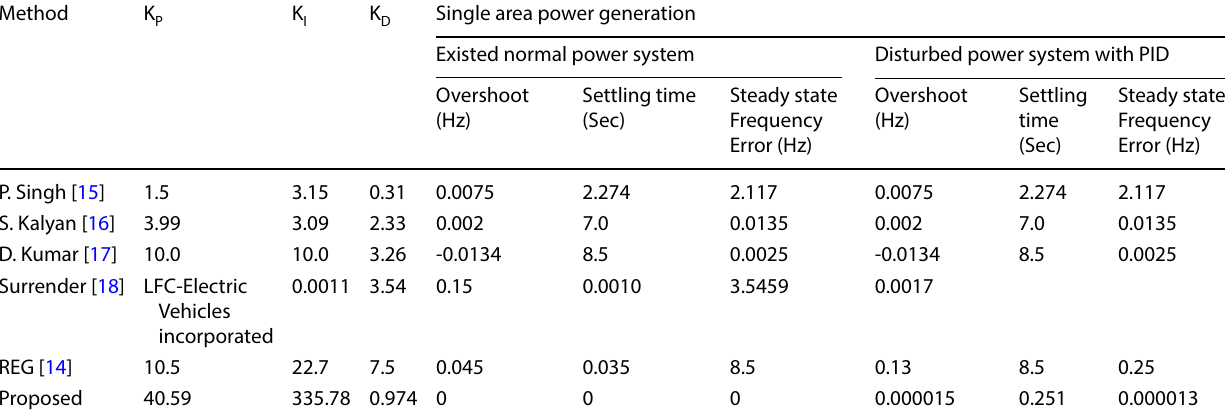
Table 4 Results comparison with the recent research findings with the proposed control technique